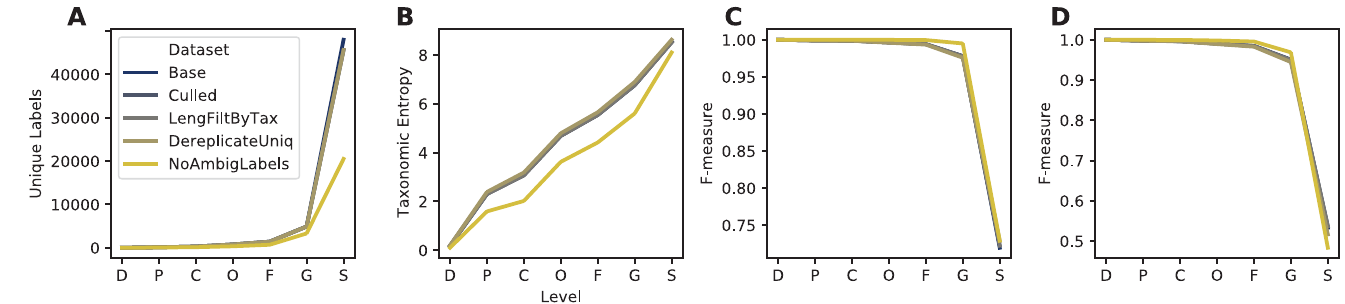
Fig 7. Comparison of taxonomic information and simulated classification accuracy across several successive steps of quality filtering of the NR99 16S rRNA gene databases. A, Number of unique taxonomic labels; B, Taxonomic entropy; C, optimal classification accuracy from the evaluate-fit-classifier action (as F-Measure) without cross-validation (simulating best possible classification accuracy when the true label is known but classification accuracy may be confounded by other similar hits in the database); D, optimal classification accuracy from the evaluate-cross-validate action (as F-Measure), which simulates pseudo-realistic classification task whereby a set of query sequences may not have an exact match in the reference database. See Fig 6 Legend for label descriptions. Rank labels on x-axis: D = domain, P = phylum, C = class, O = order, F = family, G = genus, S = species.